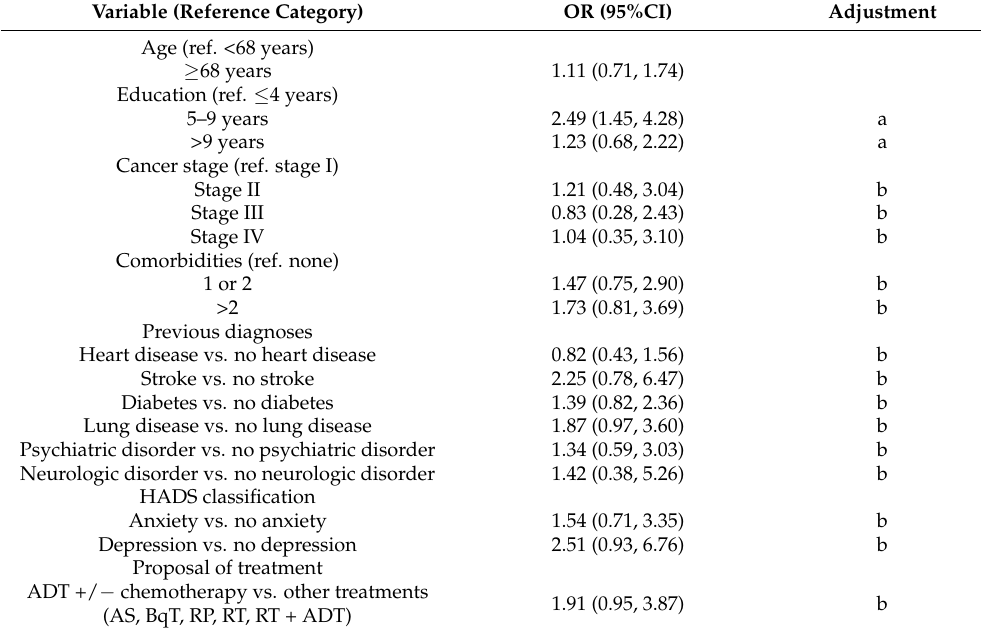
Table 3. Adjusted odds ratio (OR) of the associations between sociodemographic characteristics, clinical characteristics of the tumor, and patient-reported outcomes—anxiety and depression—with probable cognitive impairment, among patients with prostate cancer.